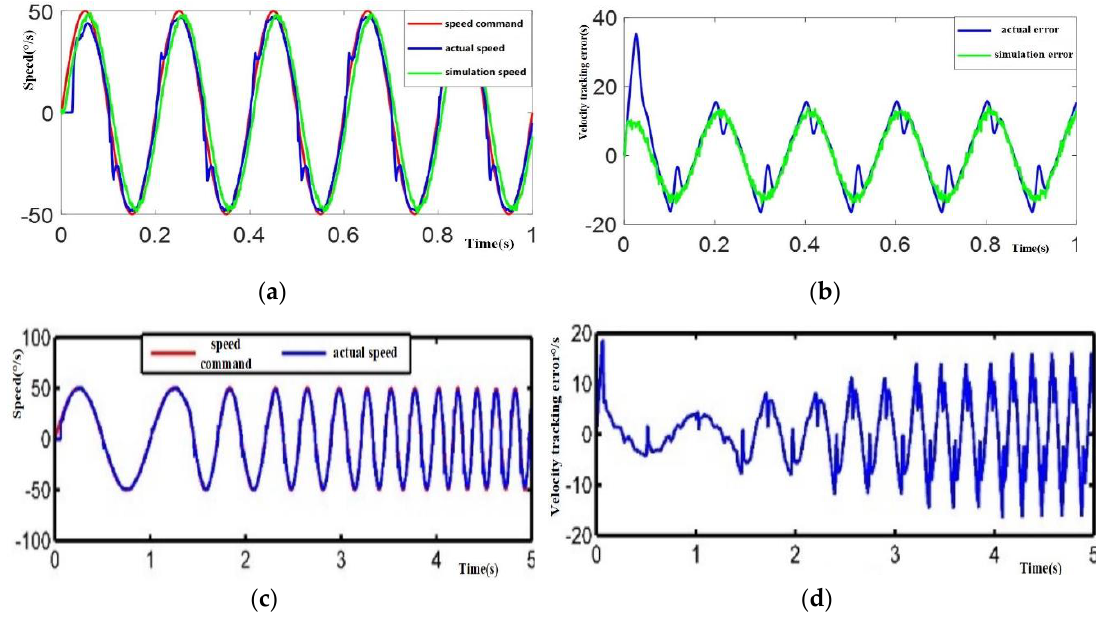
Figure 11. The sinusoidal signal disturbance suppression test of the USM. ( a ) No bias value was applied; ( b ) Applied a bias value; ( c ) Frequency gradually changes from 1 to 5 Hz; ( d ) Frequency is 5